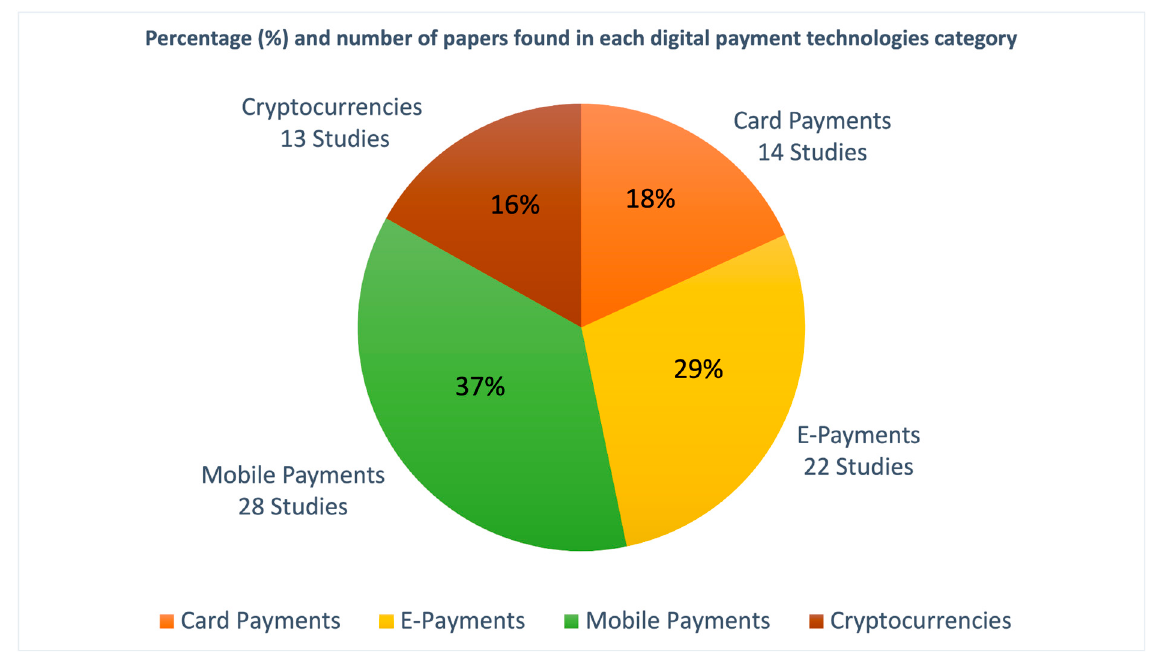
Figure 3. Percentage and number of studies conducted in each category of Digital Payment Technologies. Table 5. Empirical studies conducted on digital payment